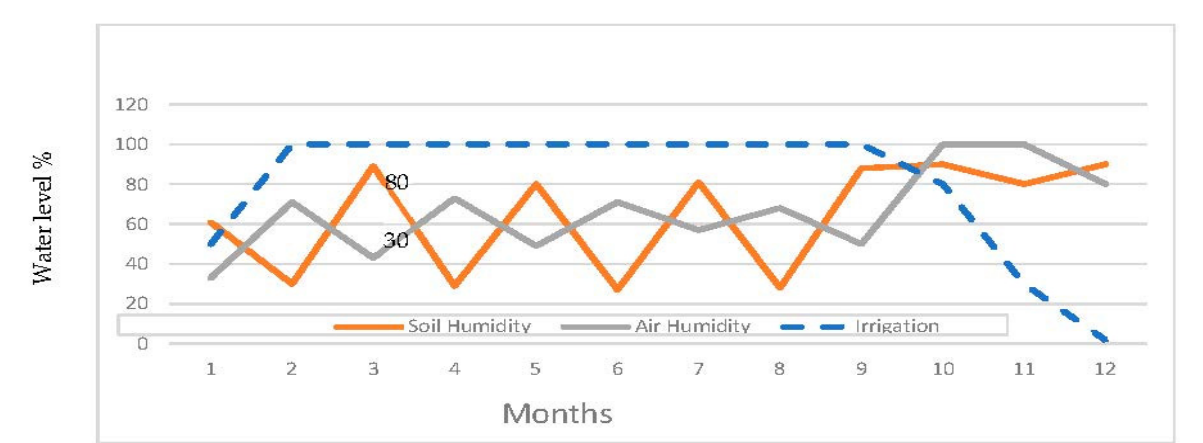
10 of 12 Figure 5. An overview of the output in a graphical format—soil moisture. The first thing to note is that, in the testing period, there are no rain periods in Saudi Arabia. This means that watering is mainly done when soil moisture is less than 30%. It is also possible to note that humidity levels in Saudi Arabia are high at that time of year, which helps the soil moisture to decline more slowly. Therefore, the water used for irri- gation can be less. The measurement of humidity parameters in the soil and the subse- quent processing of this information constitutes a fundamental element for decision-mak- ing in the technical environments of smart agriculture. This leads, for example, to estab- lishing the appropriate sowing and harvesting periods to improve the productivity of dates in Saudi Arabia. Smart farms are an especially significant aspect that must be ad- dressed by systems engineering, electronic engineering, and data science. The analysis of large volumes of information using time series, big data, data mining, and other analysis methodologies allows the finding of patterns that allow intelligent decision-making. This allows us to improve and optimize different plants in the Agro sector. Thanks to the inte- gration of the IoT and different sensors in cloud platforms, it is possible to improve many aspects related to plant growth. This includes saving on inputs and pest control.